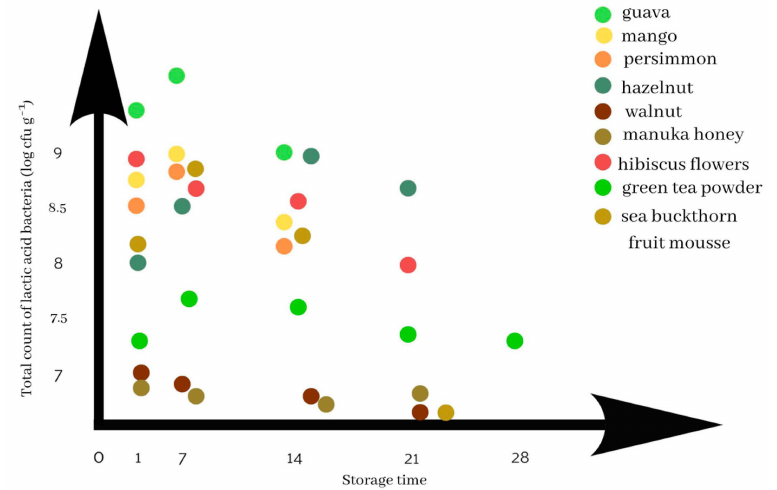
Figure 1. Microbiological changes in the yoghurts with plant additives during